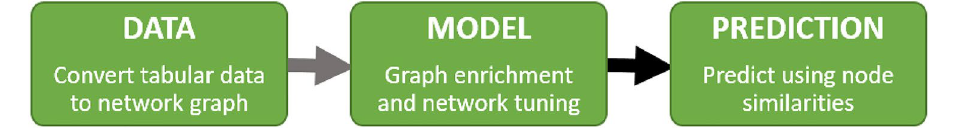
Figure 1. The brief pipeline of the GSNAc